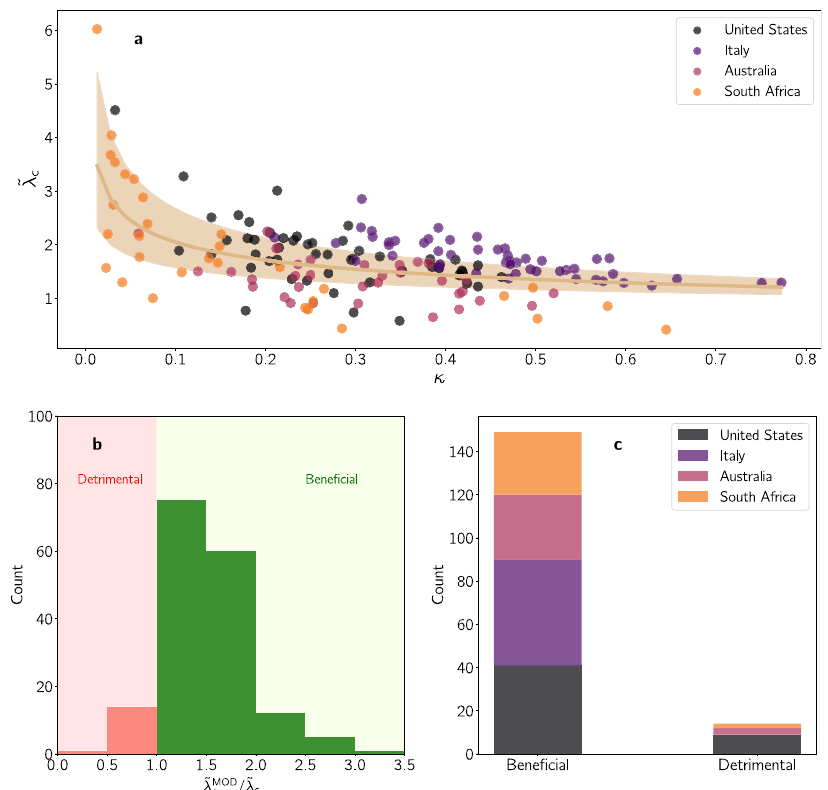
Fig. 2 Connecting morphology to vulnerability. a Normalized epidemic threshold ~ λ c vs. population density hotspot concentration κ for cities in each of the chosen four countries (color code). The Spearman correlation coef fi cient is r s = − 0.45 ( p -value < 10 − 9 ), showing a moderate but statistically signi fi cant correlation. The solid line shows the result of fi tting the data to a power-law function ~ λ c (cid:3) κ β , obtaining β ≈ − 0.25 via least squares regression. The shadowed region covers 68.2% con fi dence intervals for the estimated parameters. b Histogram for the impact of reshuf fl ing the fl ows connecting hotspots among their non-hotspots neighboring areas on the epidemic threshold, measured by the ratio ~ λ MOD threshold after reshuf fl ing. The green-colored (red-colored) zone corresponds with a bene fi cial (detrimental) effect of such intervention translated into an increase (decrease) of the epidemic threshold. c Bar plot containing the count of cities within each category according to the outcome of the removal of fl ows connecting hotspots for each country here